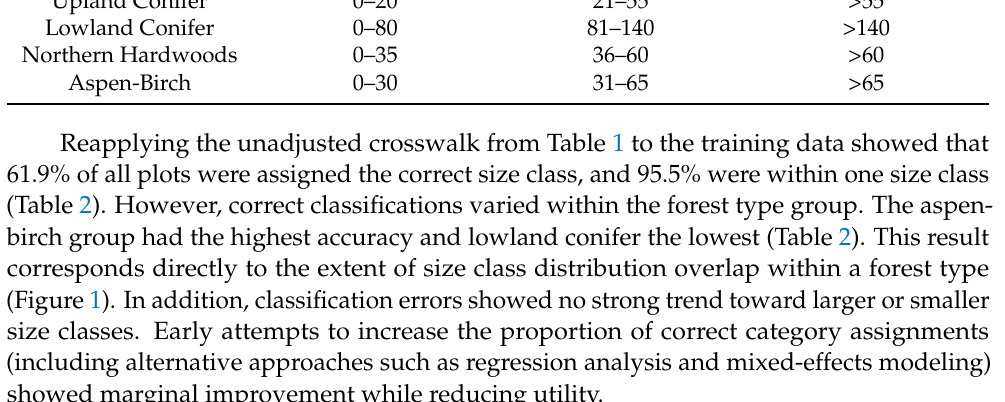
Table 2. Age class to size class crosswalk percent accuracy and error for each forest type group. Also included are the error rates across all groups and the sample sizes. Errors are reported as proportions of the observed total number of plots in the associated category. Note that the FIA size classes were coded as 1—sawtimber, 2—poletimber, and 3—seedling/sapling. Thus, negative and positive numbers represent estimates smaller and larger than the actual size class, respectively.